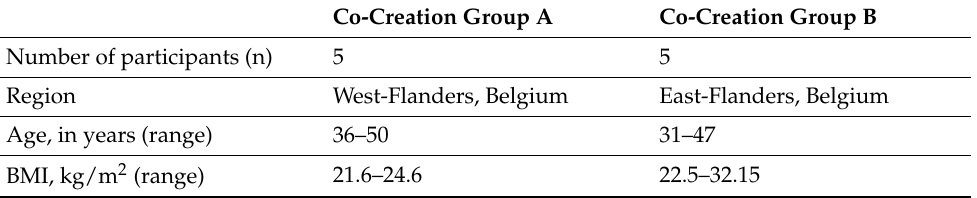
Table 2. Participant characteristics of co-creation Groups A and